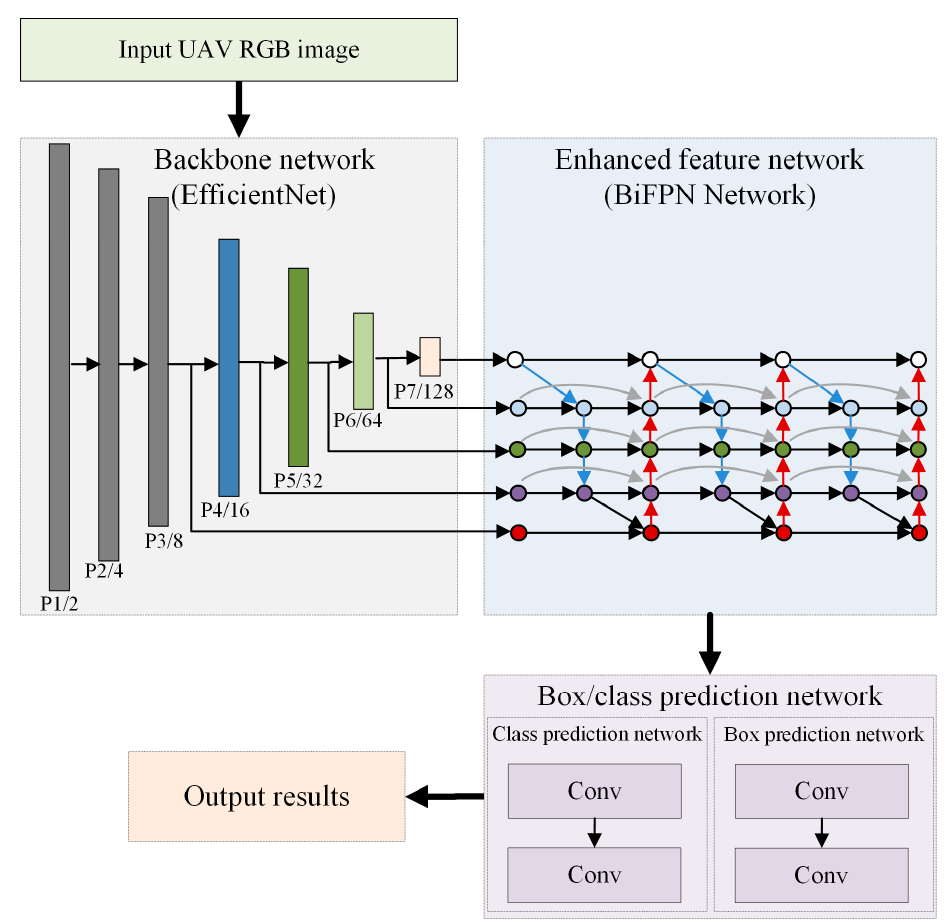
Figure 3. Architecture of EfficientDet proposed by Tan et al. [35].